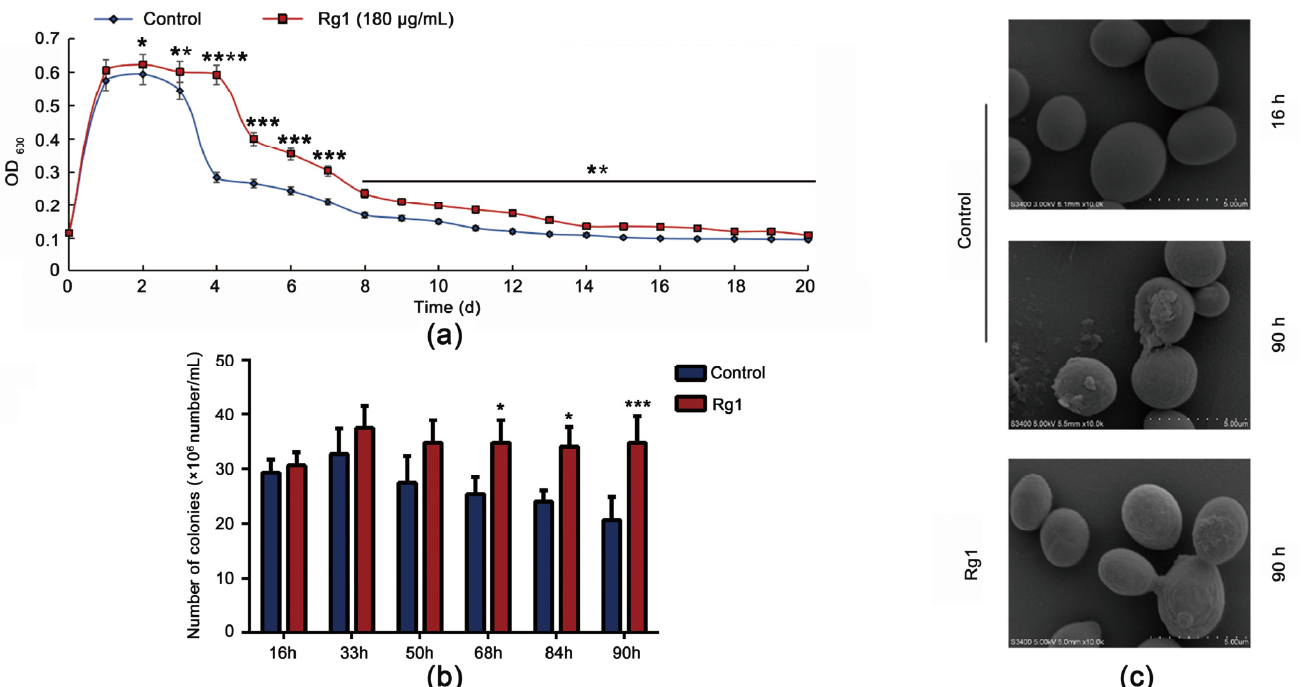
Figure 2. Ginsenoside Rg1 promotes survival and improves the morphology of S. cerevisiae cells. ( a ) Growth curves of yeast cells without or with Rg1 (180 μg/mL) treatment. ( b ) Spot number analysis of yeast cells without or with Rg1 (180 μg/mL) treatment. ( c ) Morphological changes of yeast cells under scanning electron microscopy without or with Rg1 (180 μg/mL) treatment. Data are expressed as the mean ± SD; n = 3. Compared with untreated controls, * p < 0.05, ** p < 0.01, *** p < 0.001, **** p < 0.0001.